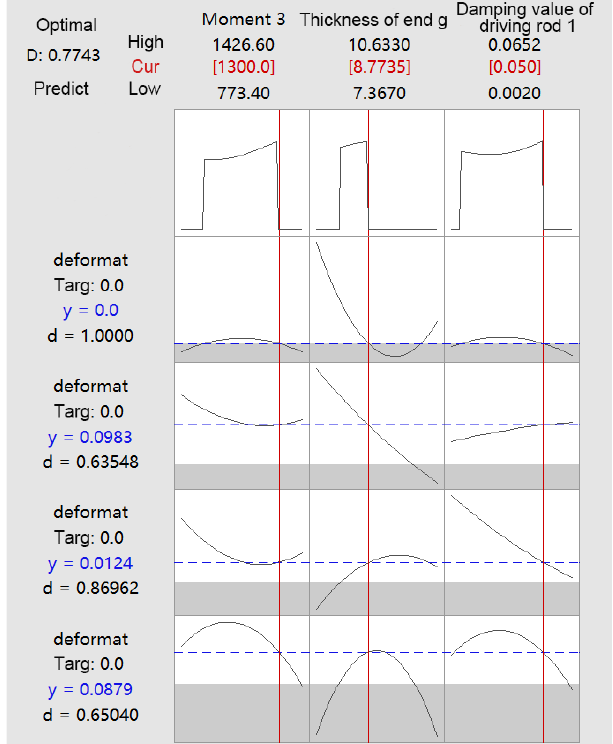
Figure 22. Optimization diagrams of coupling effects design. Table 9. Optimization graph results of coupling effects design.